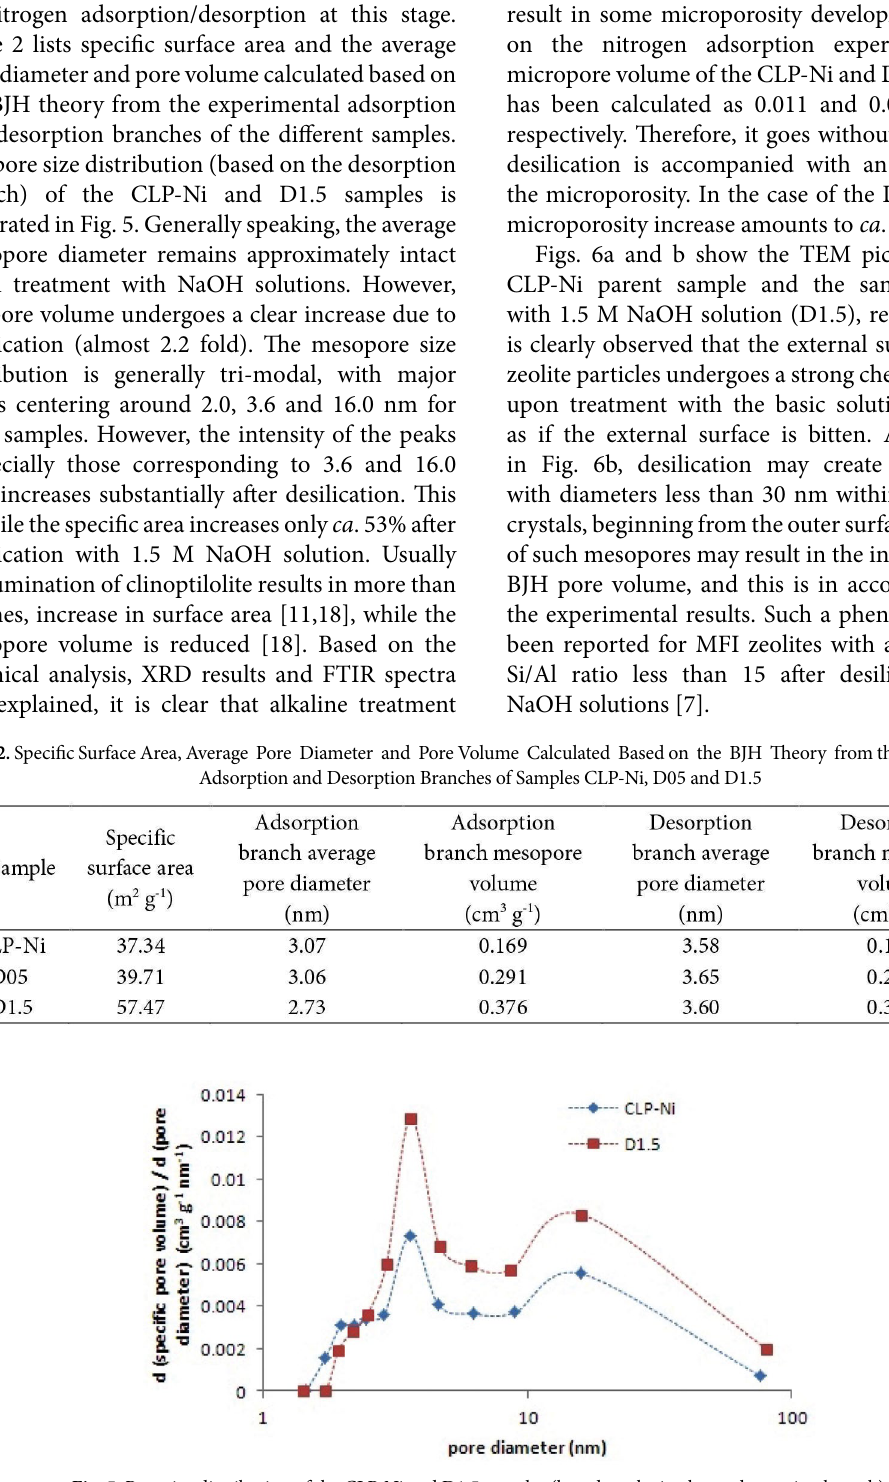
Fig. 5. Pore size distribution of the CLP-Ni and D1.5 samples (based on the isotherm desorption